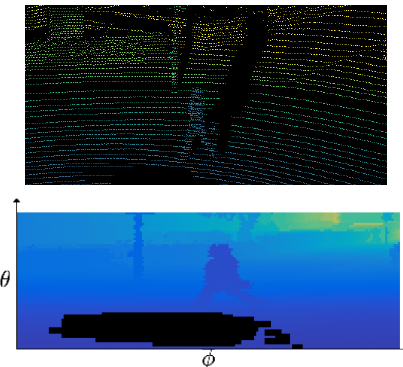
Figure 3. Example of a point cloud from the KITTI database (top) turned into a range image (bottom). Note that the black area in (b) corresponds to pulses with no returns. number of consecutive scanlines and thus a temporal dimension.